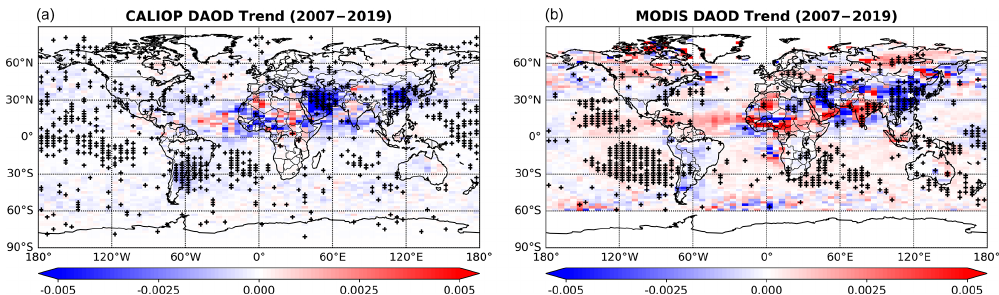
Figure 14. Global map of DAOD trend based on CALIOP (a) and MODIS (b) dust climatology data over 2007–2019 period. Red and blue represents increasing and decreasing trend, respectively. The “ + ” symbol denotes trends with p value < 0.05, which are considered as statistically meaningful trends.